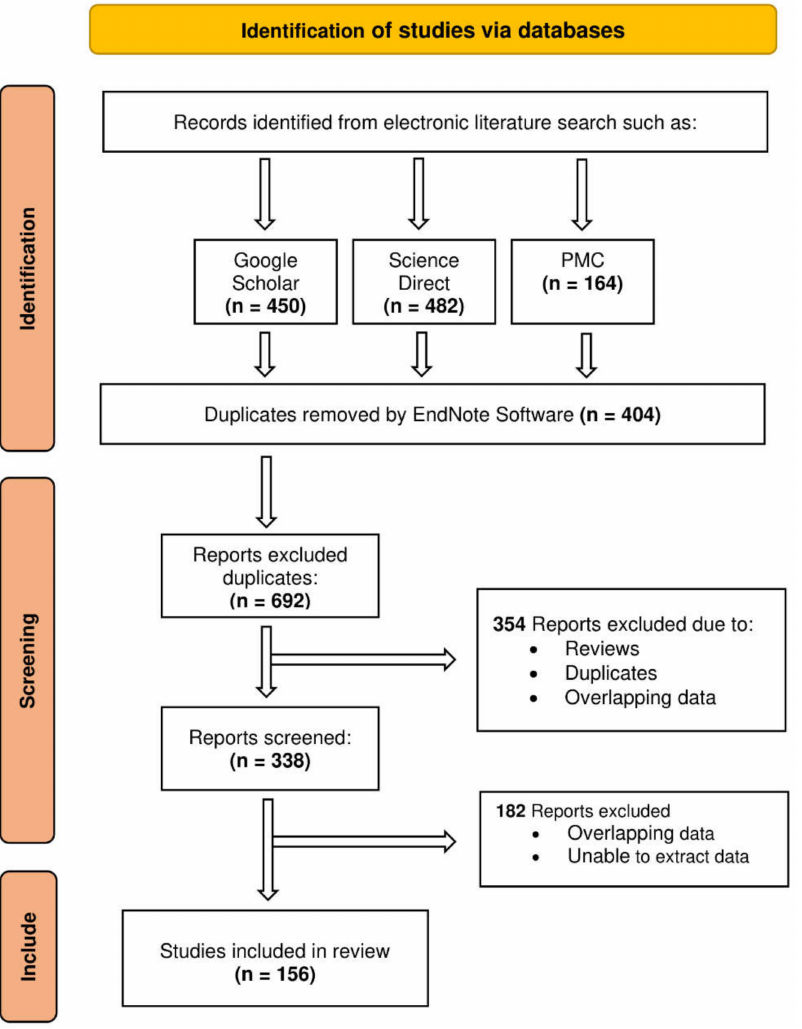
Figure 2. Prisma flow diagram of the